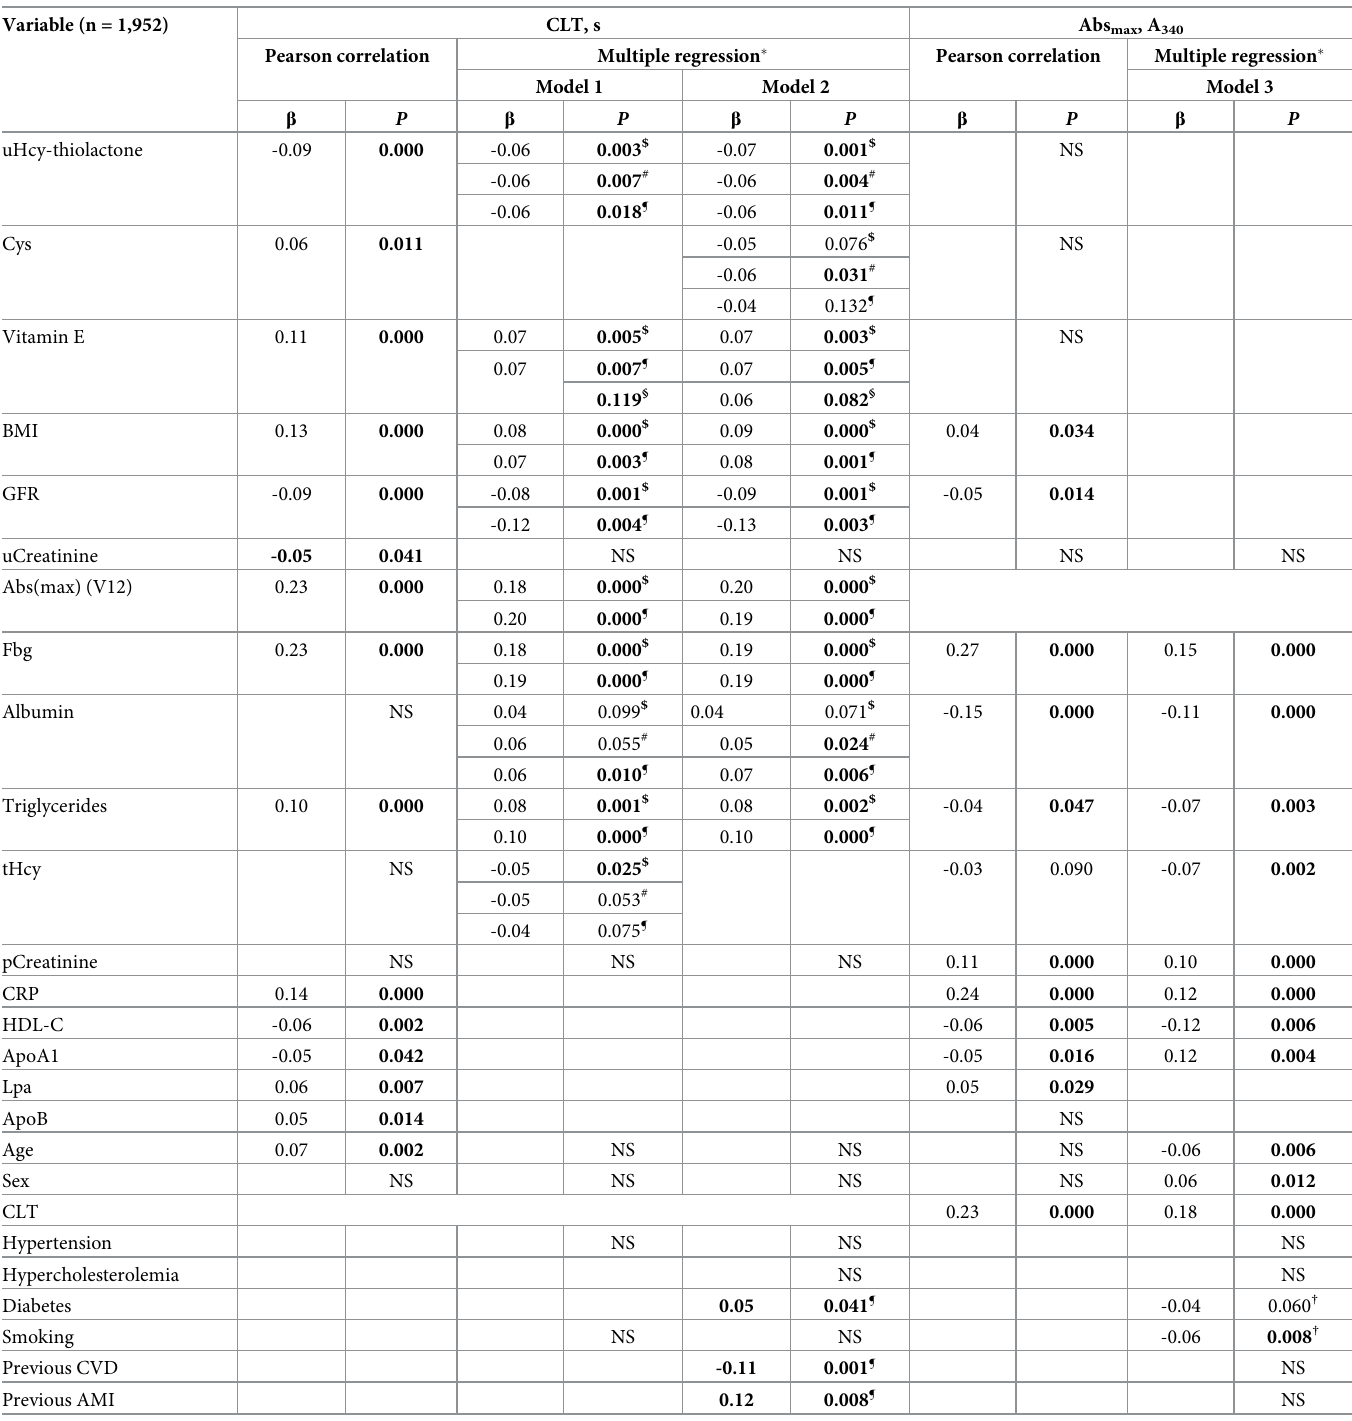
Table 2. Determinants of plasma fibrin clot lysis time (CLT) and maximum absorbance (Abs max ). Variable (n =